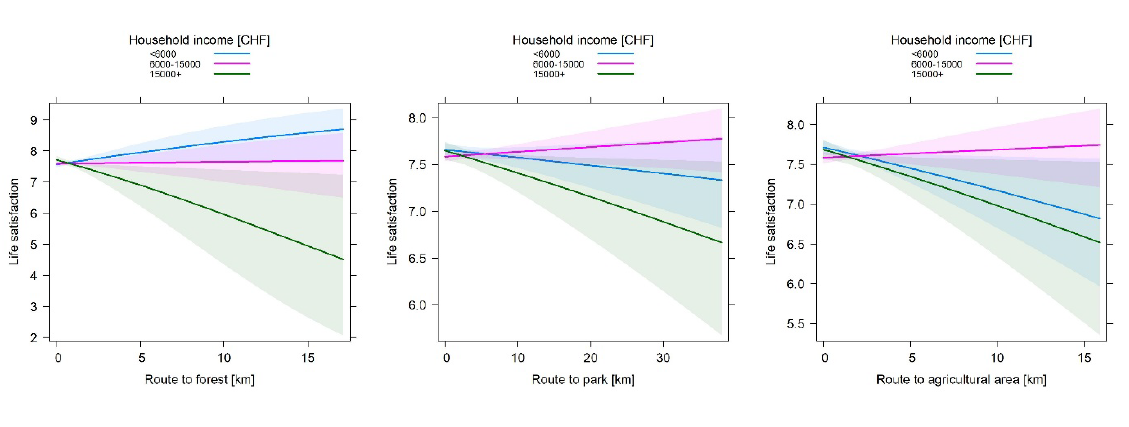
Figure S7 . Mutually adjusted associations of proximity to greenspace with life satisfaction by household income, adjusted for life satisfaction in the past, age categories, sex, financial worries, canton, degree of urbanisation, month of entry, and NDVI